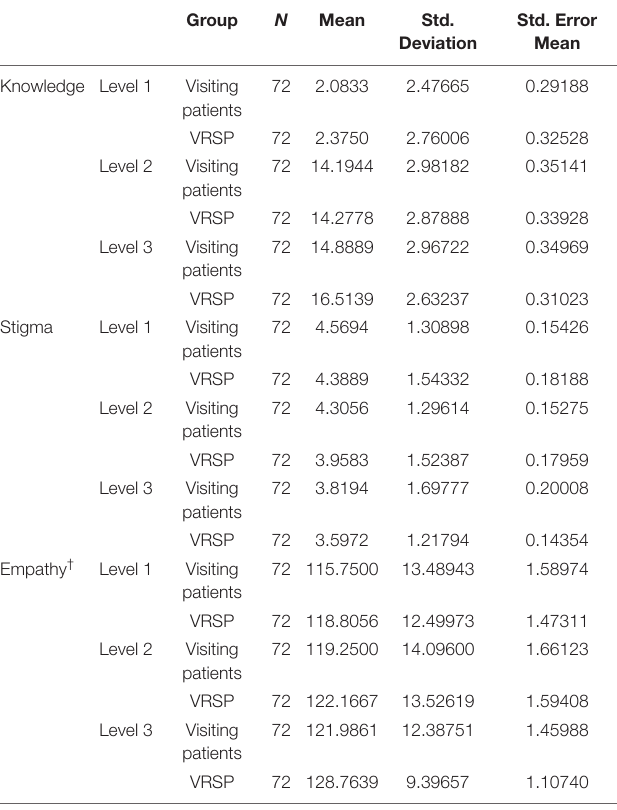
TABLE 2 | Means and standard deviations of scores in two groups in 3 stages of assessment.